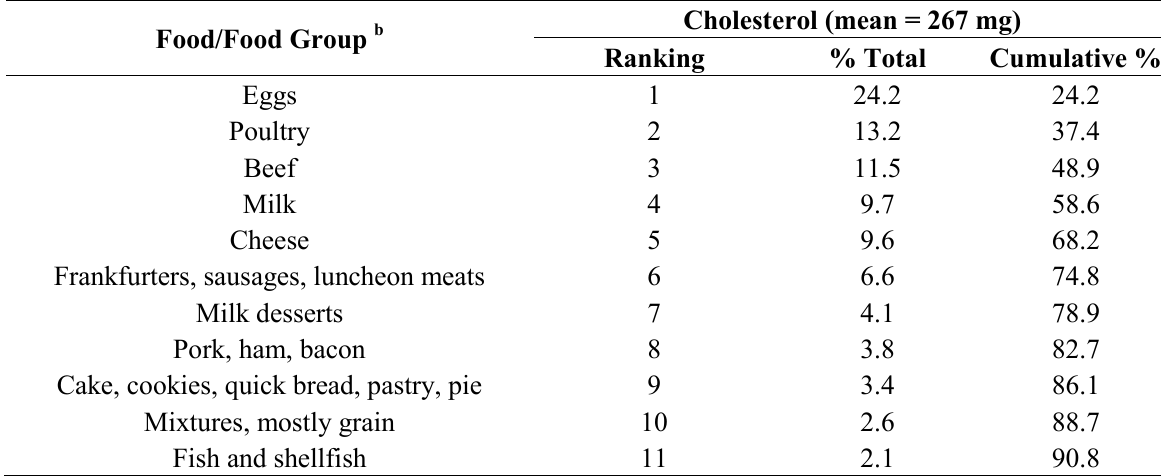
Table 9. Food/Food group sources of cholesterol among US children aged 2–18 years (from NHANES 2003–2006) a .